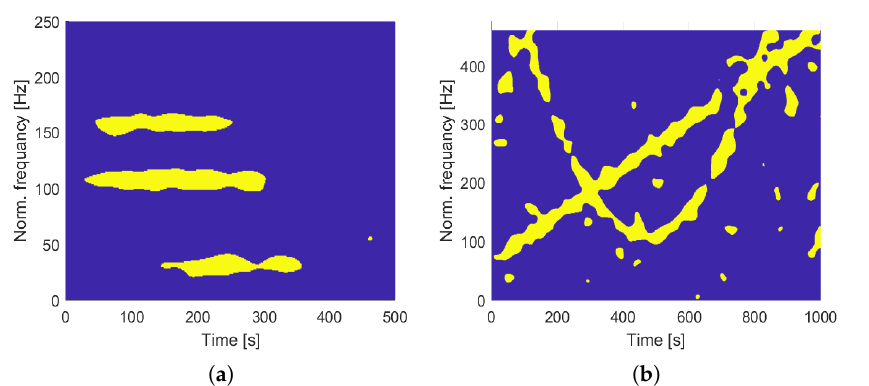
Figure 13. Extracted useful information content obtained by applying the 2DLEM method obtained with the proposed measure based on the generalized Dombi operator for SNR = 0 dB. ( a ) Classification mask for the first signal. ( b ) Classification mask for the second signal.